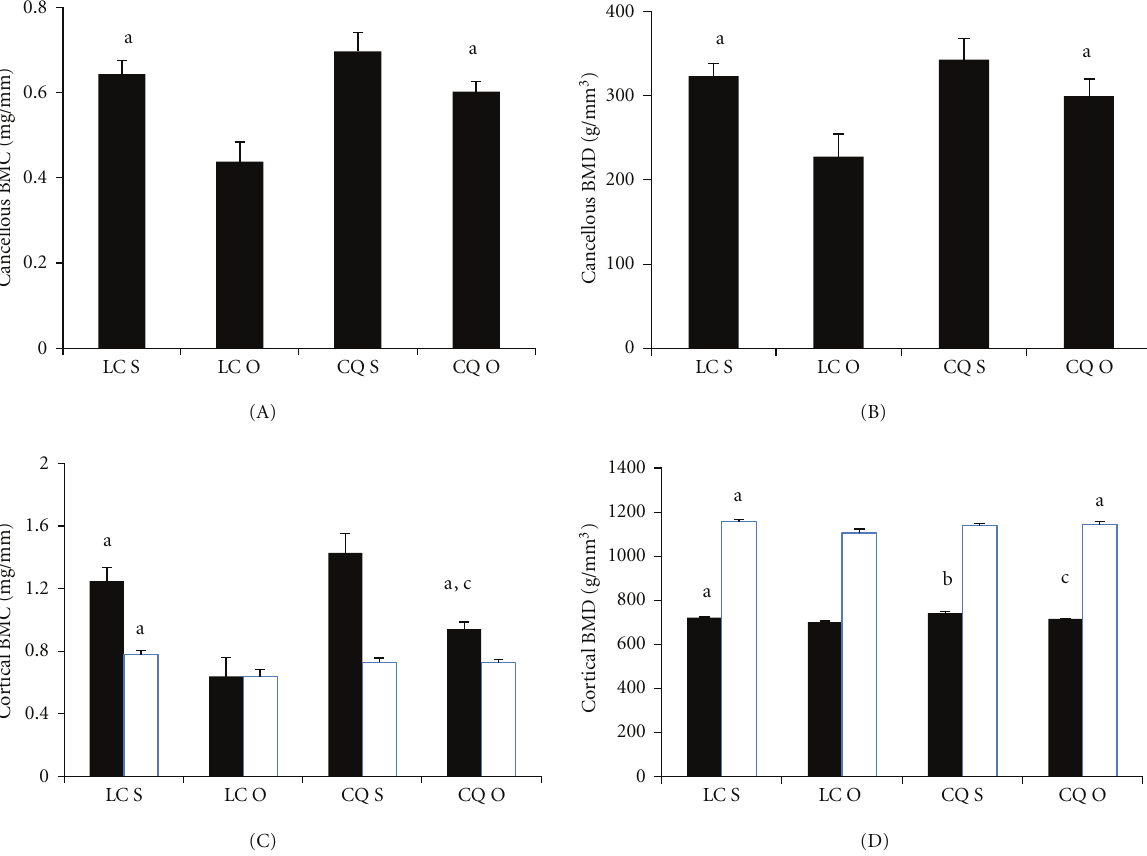
Figure 3: E ff ects of Cissus quadrangularis on the cancellous and cortical bone parameters of the proximal tibial metaphysis and tibia fibula junction of C57Bl/6 mice after ovariectomy using pQCT. Data are Mean ± SE. (A) cancellous BMC; (B) cancellous BMD; (C) cortical BMC; (D) cortical BMD. Black bars represent distal femoral metaphysis; White bars represent femoral diaphysis. LC S: lab chow sham; LC O:lab chow ovariectomy; CQ S: Cissus quadrangularis sham; CQ O: Cissus quadrangularis ovariectomy. a P < 0 . 05 versus LC O; b P < 0 . 05 versus CQ S; c P < 0 . 05 versus LC